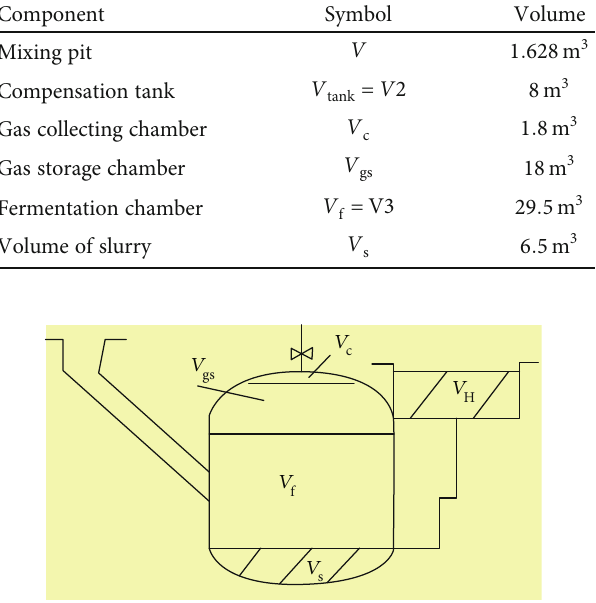
Table 9: Measured value for some property during the baking of